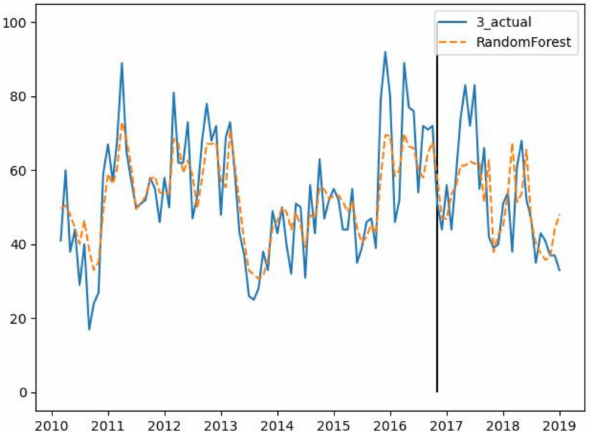
Figure 10. Random forest’s fitting and prediction results for group